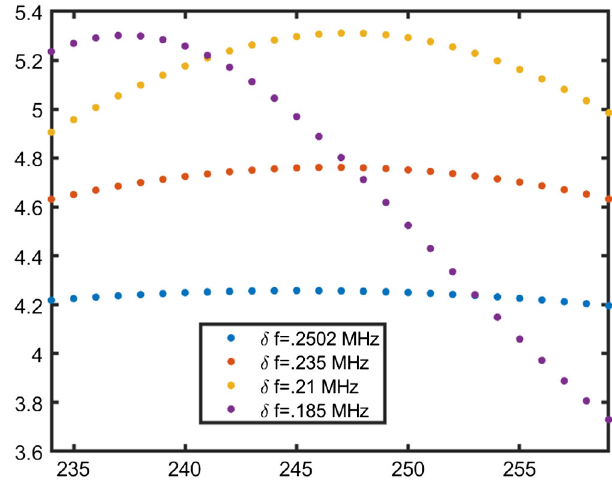
FIG. 17. ρ ð z Þ of the last bunch in a train of 26, by macroparticle simulation (red dots) and Haïssinski solution (blue curve).